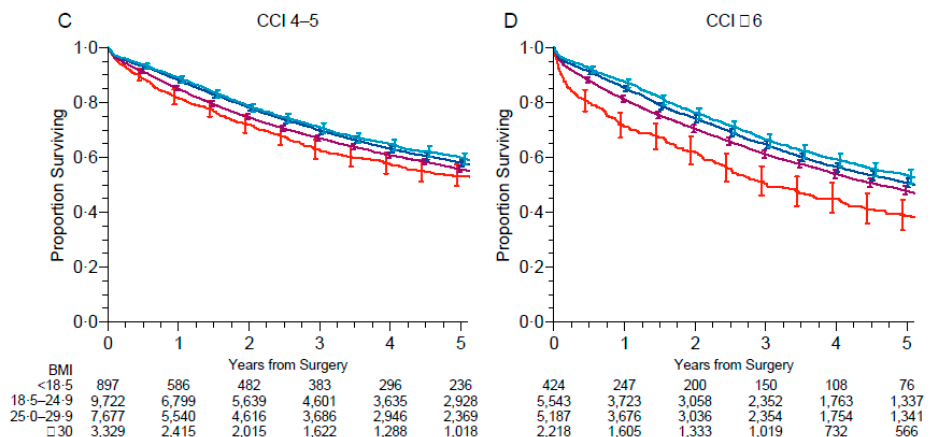
Figure 4. Survival according to BMI and Charlson comorbidity index (CCI) categories: 0–2 ( A ), 3 ( B ), 4–5 ( C ), >6 ( D ).